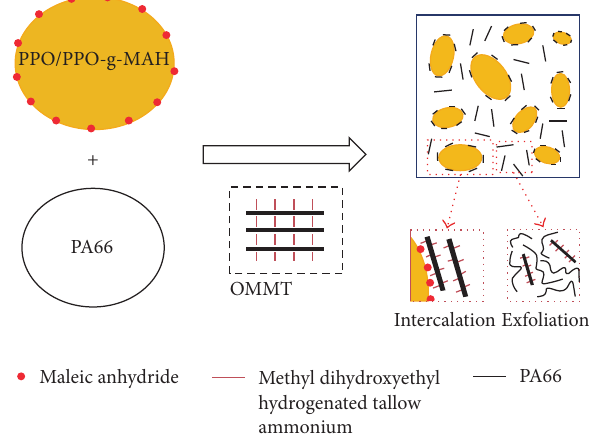
Figure 3: Schematic diagram for dispersion of OMMT in PPO/PA66